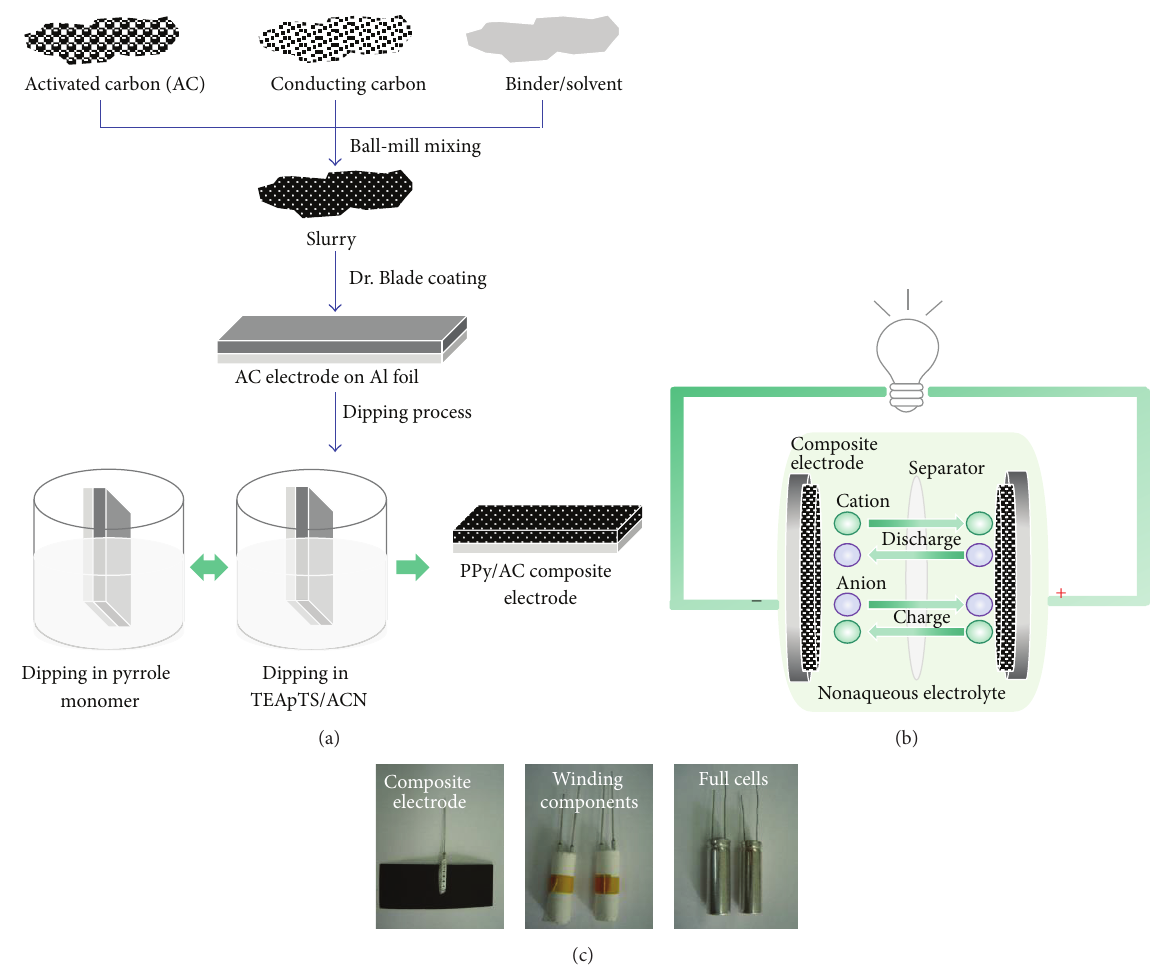
Figure 1: (a) Schematic illustration of the preparation of the PPy/activated carbon composite electrode. (b) Schematic illustration of the nonaqueous supercapacitor. (c) Digital photography of the components for the nonaqueous supercapacitor.